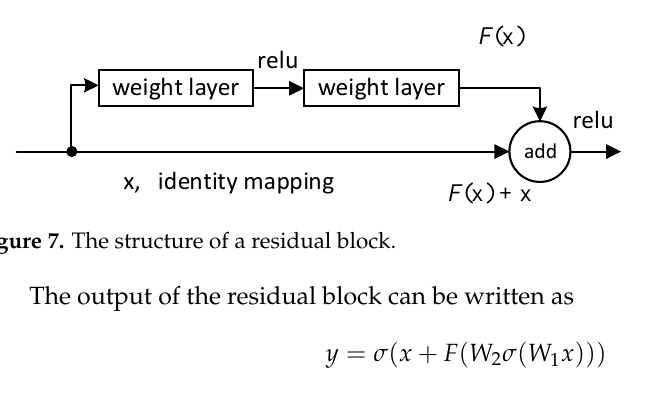
Figure 6. The processes of the TFDI denoising (SFM is selected at –6 dB as an example).